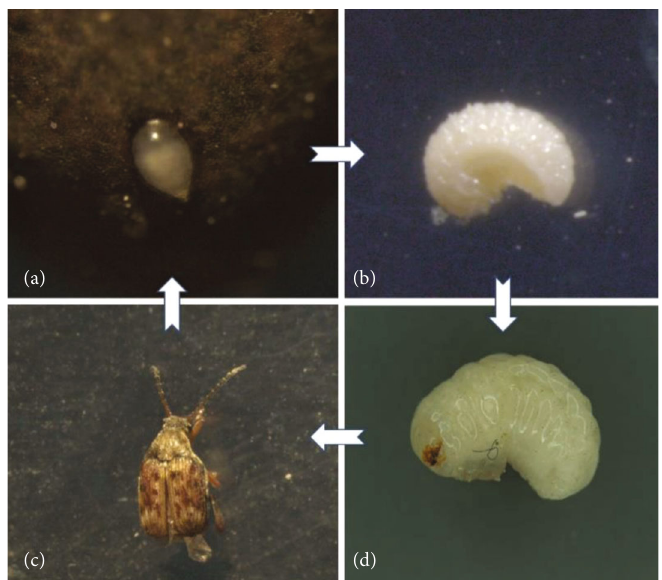
Figure 1: A microscopic image of Callosobruchus maculatus: (a) egg; (b) larva; (c) pupa; (d) adult